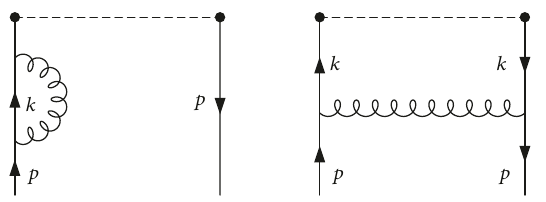
Figure3:One-loopdiagramsenteringthecalculationofquasidistri- butions: self-energy corrections (left) and vertex corrections